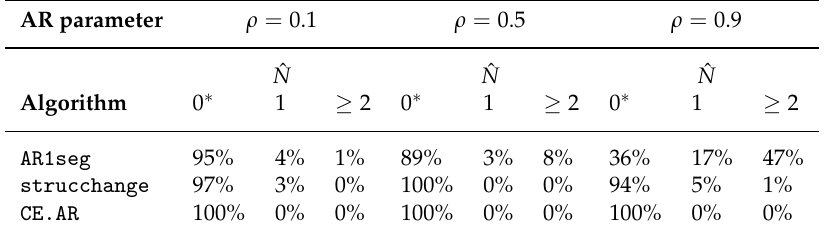
Table 1. The estimated number of change-points in an AR(1) with no change points.